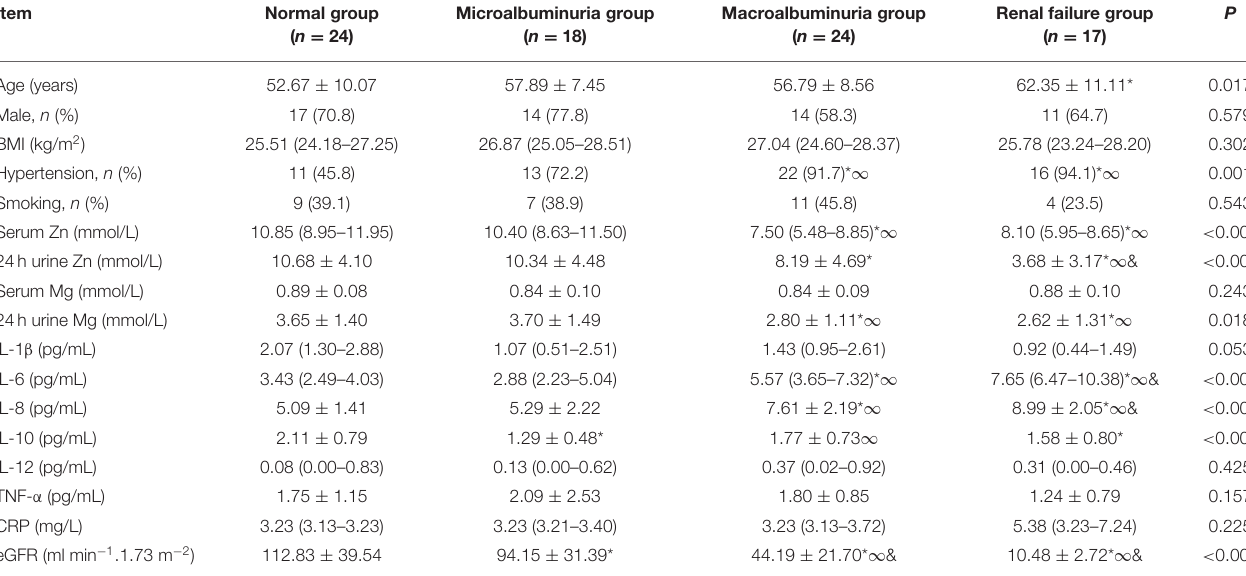
TABLE 4 | Demographic and biochemical parameters of patients with different degrees of DN.